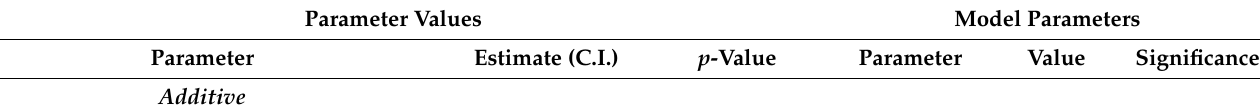
Table 2. Geospatiotemporal Models for